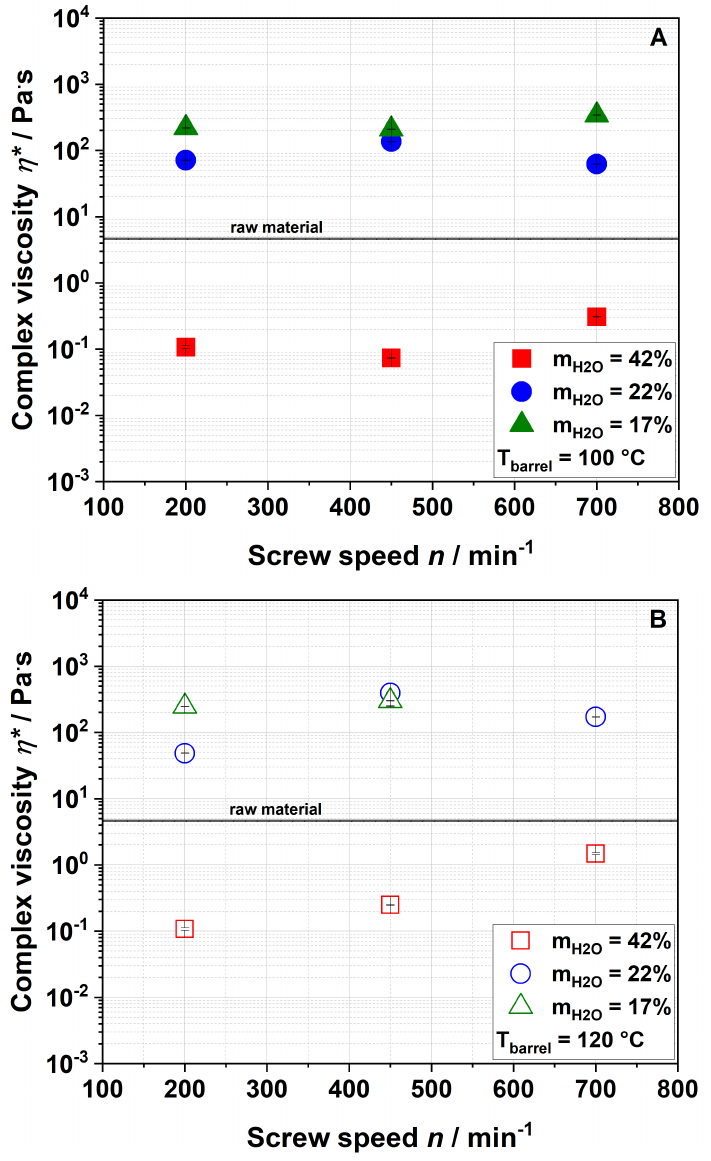
Figure 6. E ff ect of screw speed and water content on complex viscosity η * at ( A ) 100 ◦ C barrel temperature and ( B ) 120 ◦ C barrel